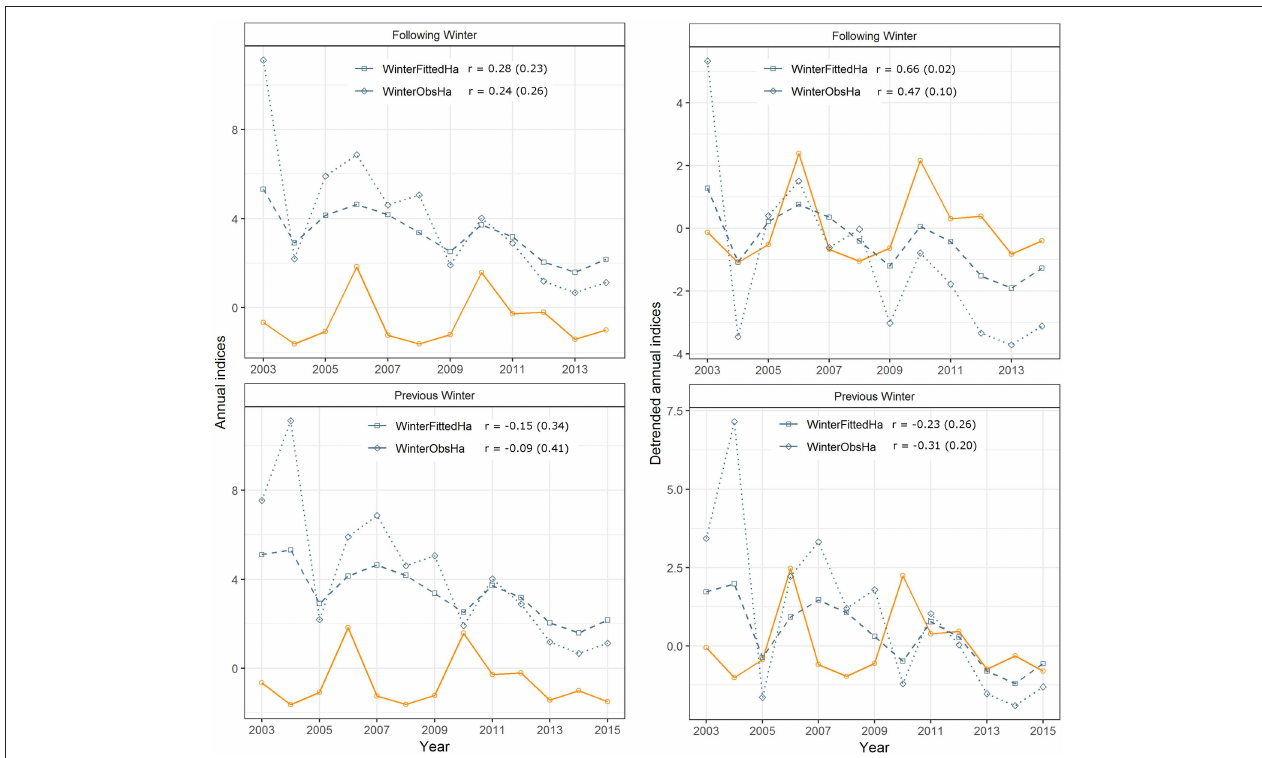
FIGURE 2 | Raw and detrended monarch butterfly annual indices for the breeding population (orange) and for two estimates of the overwintering population (fitted hectares and observed hectares), comparing breeding indices with the previous (bottom), and following (top) winter. Significant correlations ( r , p -value in parentheses) were detected between the detrended breeding annual indices and detrended fitted hectares and density estimates for the overwintering population ( Table 3 ; density not shown).